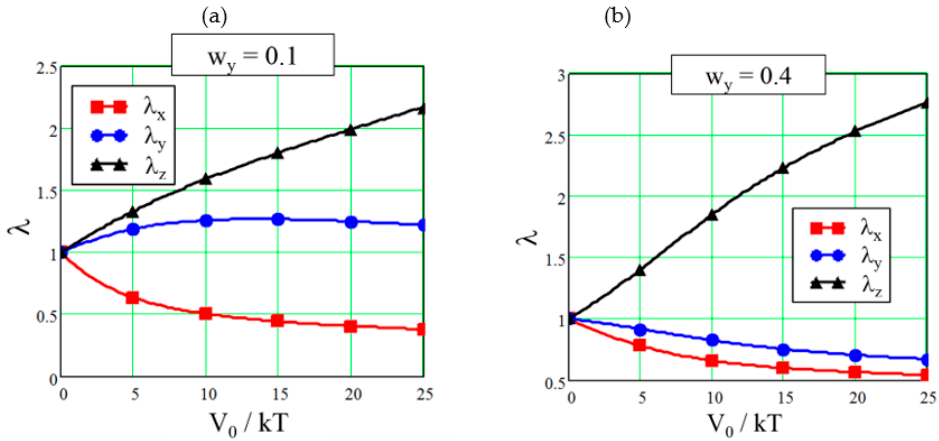
Figure 4. Elongation ratios λ x,y,z as functions of the parameter V 0 /kT at w y = 0.1 ( a ) and w y = 0.4 ( b ) for an azo-network with q = 1.